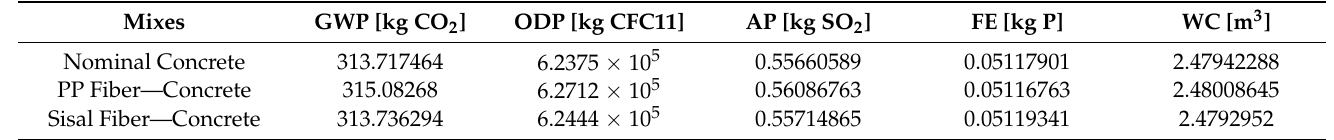
Table 7. ReCiPe Midpoint H method results for 1 m 3 of concrete